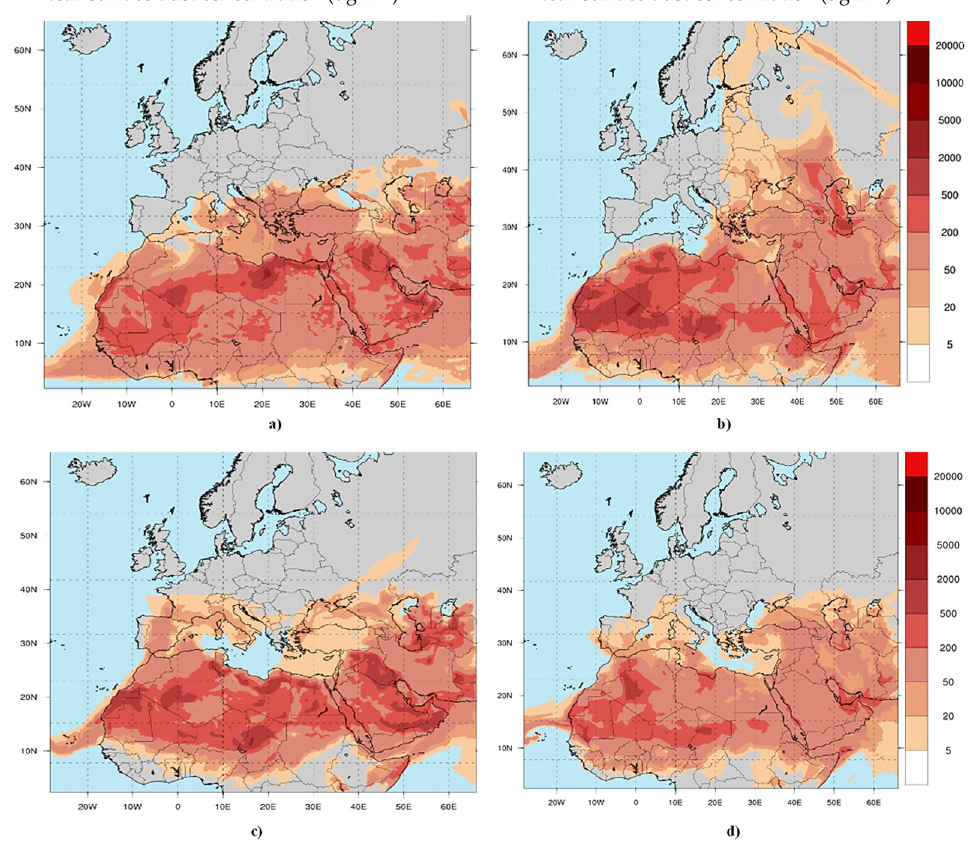
Figure 1. Maps for dust aerosol prediction using the WRF-Chem model for 20.05.2020 ( a ) 10.06.2020 ( b ) 30.07.2020 ( c ) and 13.09.2020 ( d ).